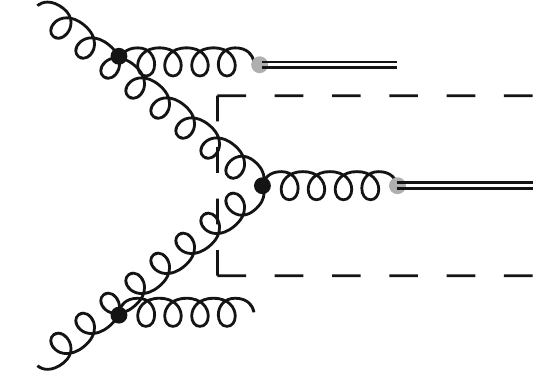
Fig. 1 Contributiontothe J /ψ pairproductionfromthefragmentation ofgluoncascade.Thedashedlineenclosesthehardsubprocess g ∗ g ∗ → g ∗ , the rest of the diagram describes the initial state radiation